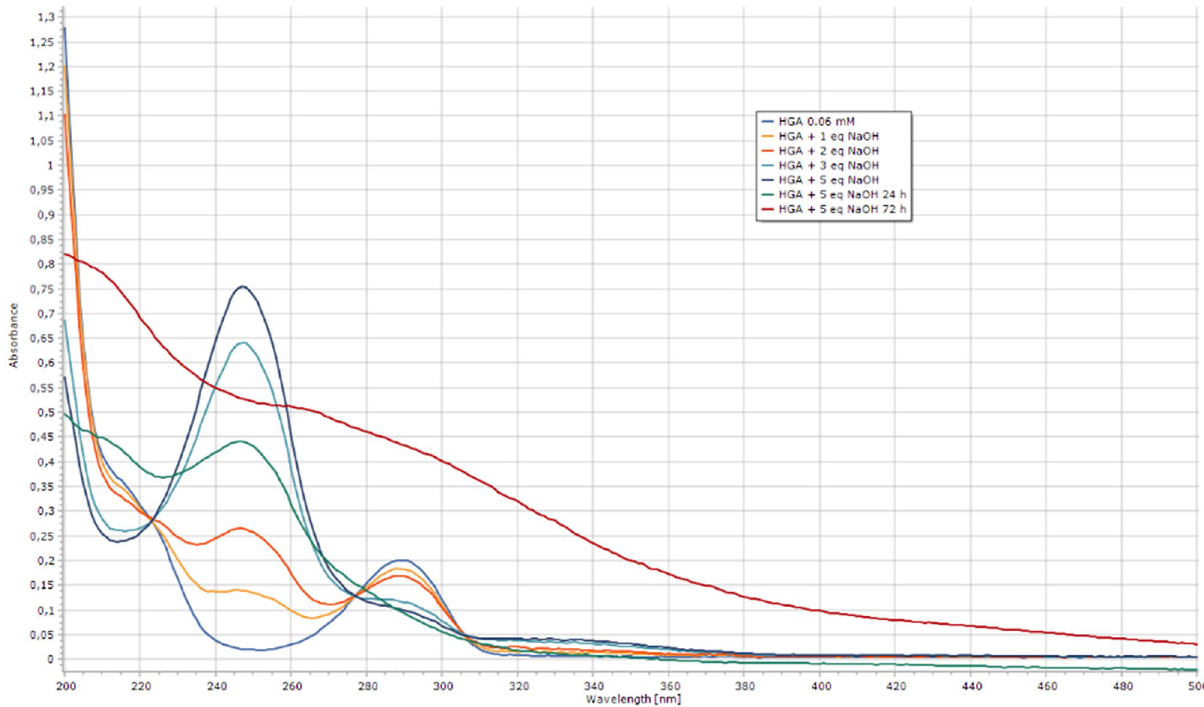
Figure 7. UV spectra of HGA in NaOH (0.06 mM) and the corresponding spectra after the addition of 1 to 5 equivalents of NaOH and after 24 and 72